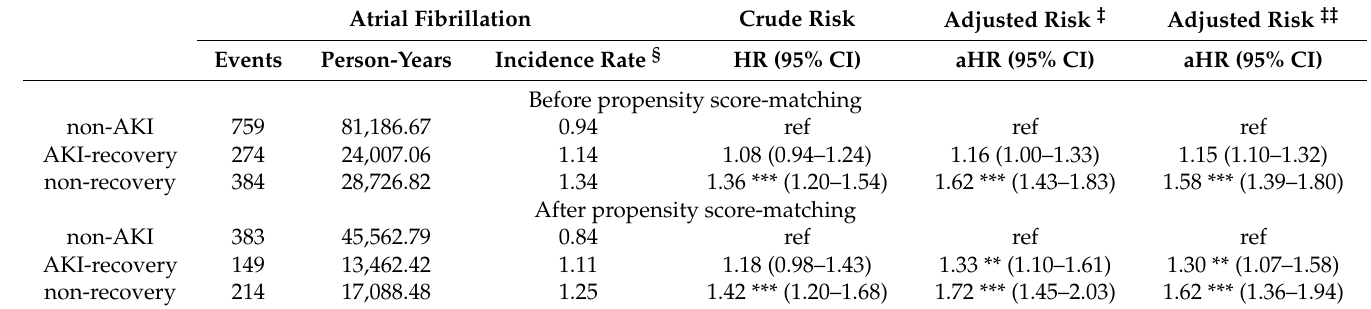
Table 3. Incidences and risks of atrial fibrillation development among the three